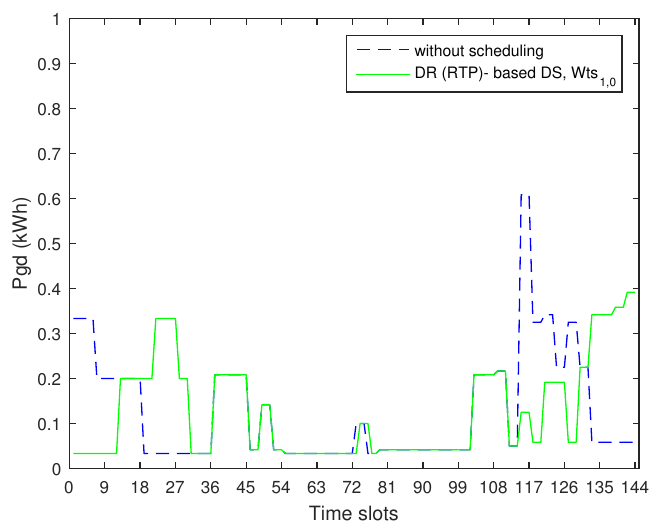
Figure 13. Load profile with maximal reduction in CE for DA-RTP (DS).